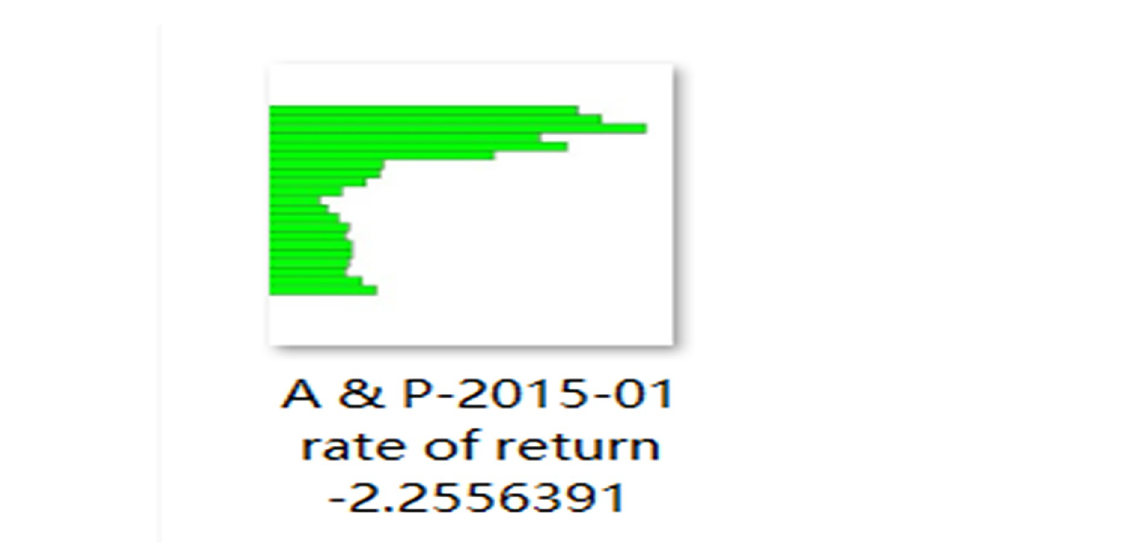
Fig 4. Sample chart